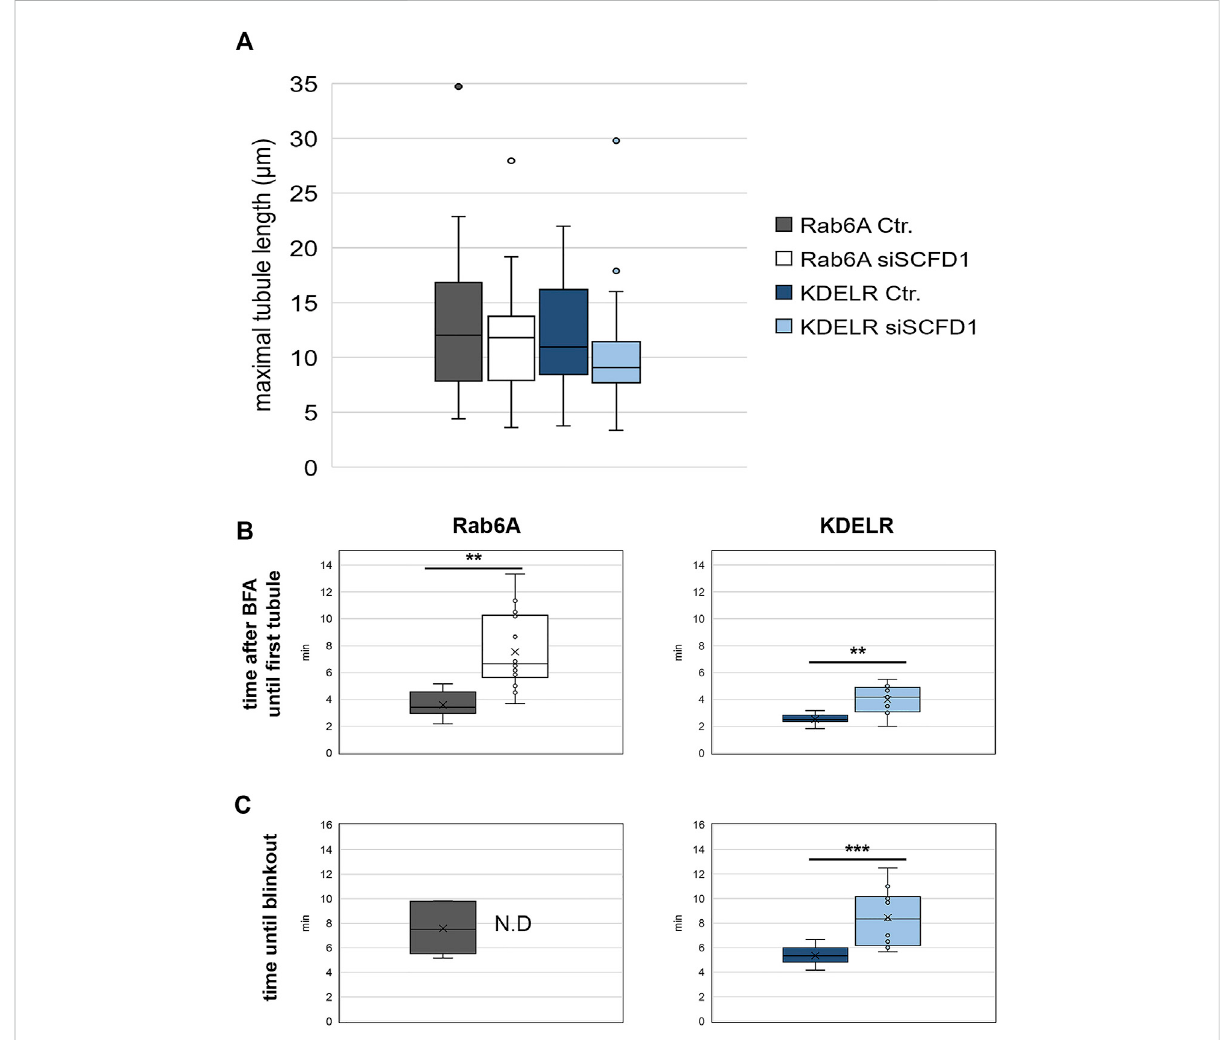
FIGURE 8 QuantitativeanalysisofEGFP-Rab6AandEGFP-KDELRtubulesafterBFAtreatment.HeLaKyotocellsweretransfectedwithsiRNAsfor48 hand then transfected with constructs encoding either EGFP-Rab6A or EGFP-KDELRfor 12 hand treated with 10 μ g/mlBFA. Confocal time-lapse images were taken every 10 s for a total of 15 min or until the redistribution of the Golgi marker to the ER was complete within this time. (A) Maximal tubule lengthfornegativecontrol(NEG)andsiSCFD1treatedEGFP-Rab6AorEGFP-KFDELRexpressingcells.They-axisrepresentsthemaximaltubule length (µm). (B) Quantitative analysis of the time after BFA treatment until the fi rst tubule was visible in negative control (NEG) and siSCFD1 treated EGFP-Rab6A and EGFP-KDELR expressing cells. The y-axis represents the time after BFA treatment until the fi rst tubule was observed (min). (C) Quantitative analysis of the time after BFA treatment until full ER redistribution (blinkout) of the Golgi marker occurred in negative control (NEG) and siSCFD1 treated EGFP-Rab6A and EGFP-KDELR expressing cells. The y-axis represents the time after BFA treatment until blinkout (min). A paired two-sided student ’ s t-test was performed. P < 0.01 **, p < 0.01